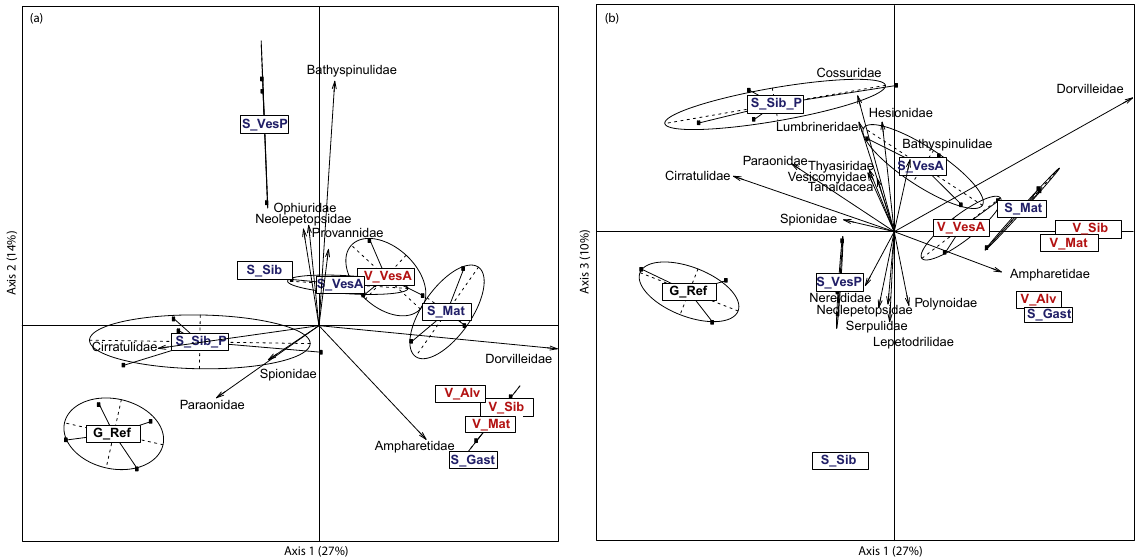
Figure 8. Between-group principal component analysis (PCA) on Hellinger-transformed macrofaunal densities of the 26 sampling units studied in the Guaymas Basin. (a) The axis 1 accounts for 27% of the variance in the macrofaunal data and axis 2 accounts for 14%. (b) The axis 1 accounts for 27% of the variance in the macrofaunal data and axis 3 accounts for 10%. Only taxa contributing to more than 2% to an axis are